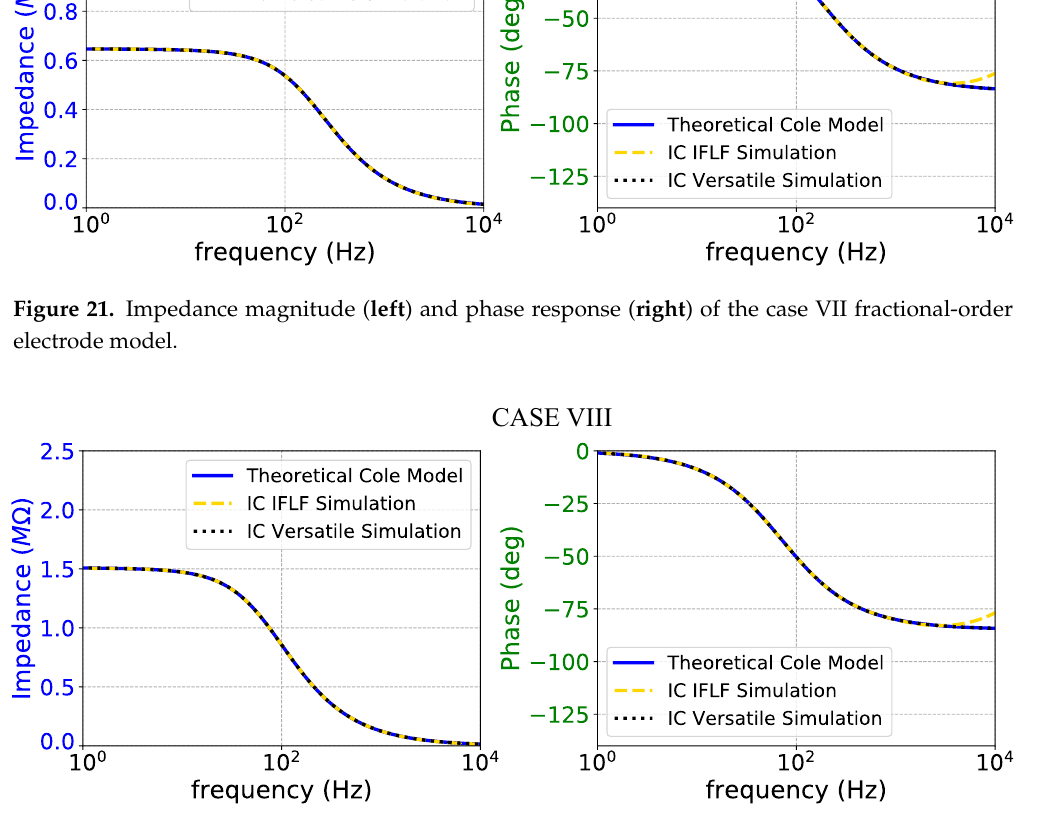
Figure 22. Impedance magnitude ( left ) and phase response ( right ) of the case VIII fractional-order electrode